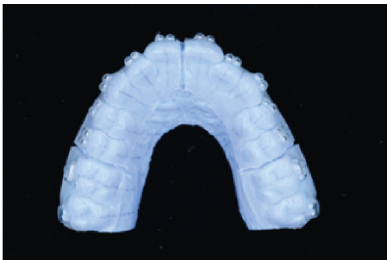
Figure 5: The vacuum-formed transfer tray after being cut into four